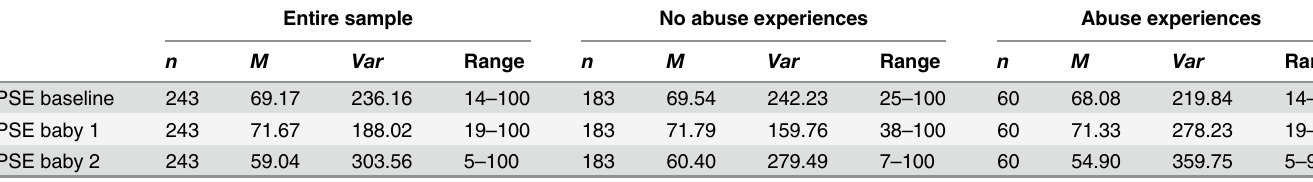
Table 1. Descriptive Statistics for PSE Measurements during the Cry Response